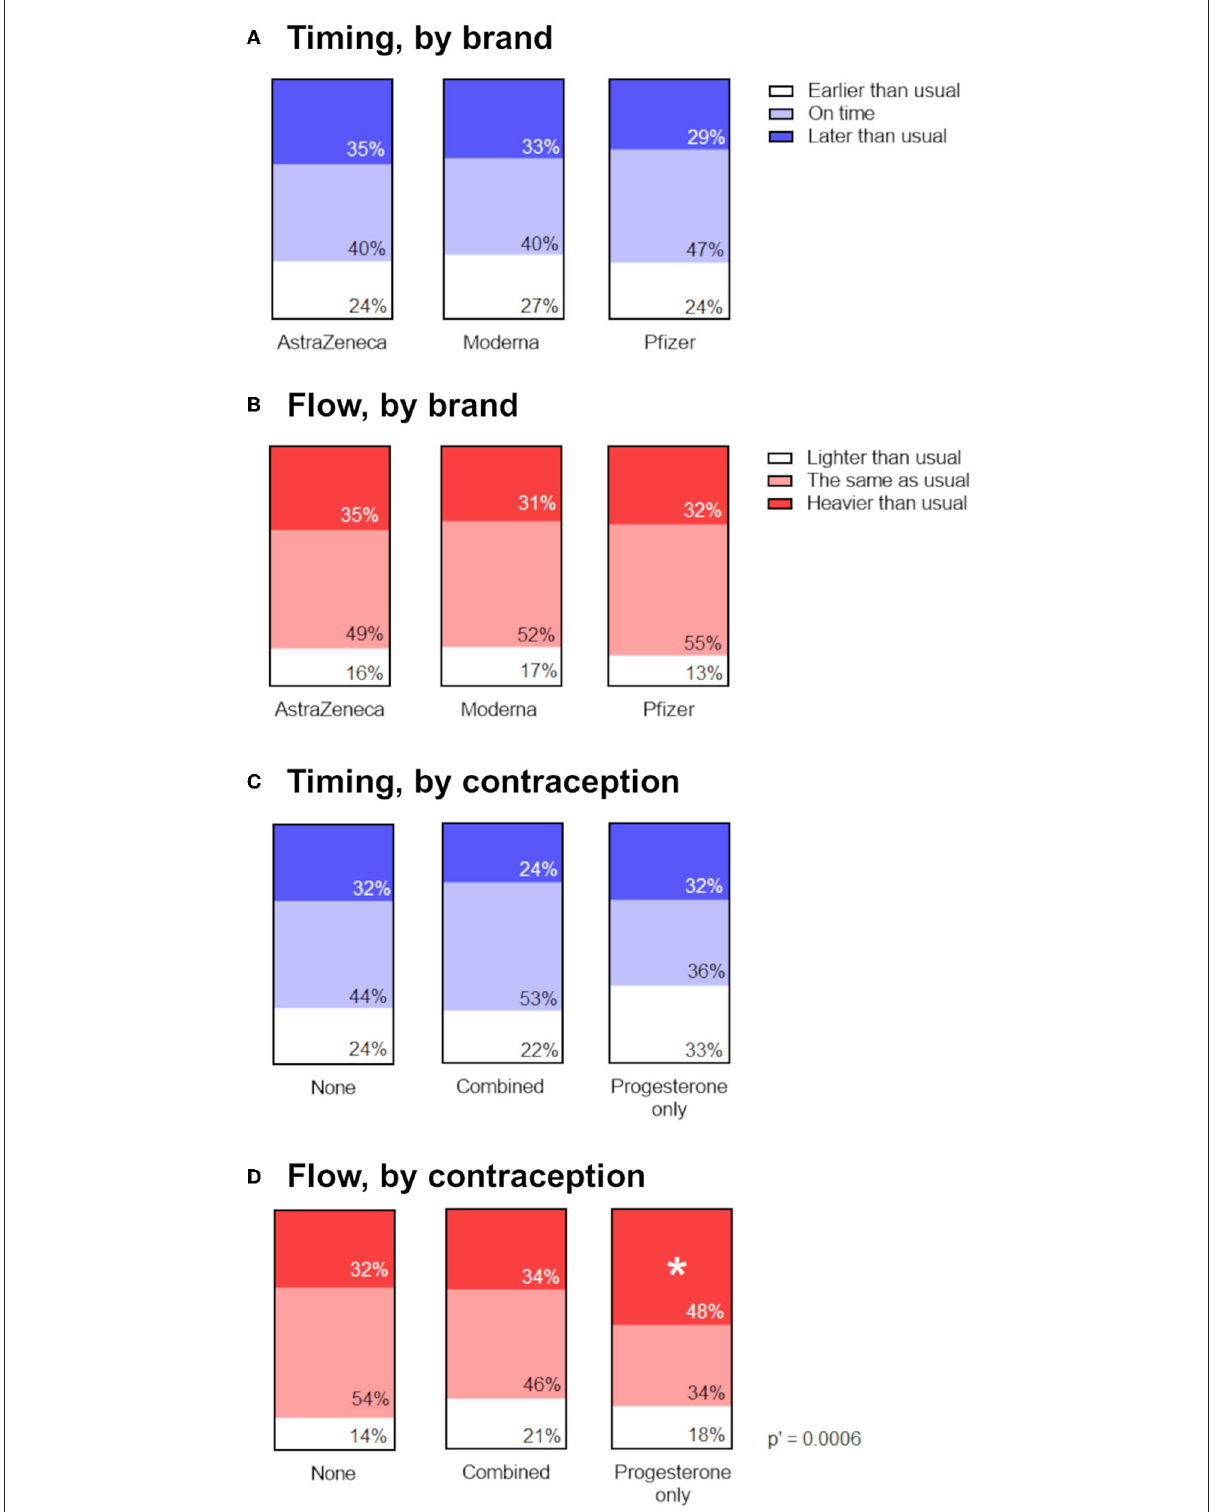
FIGURE3 Associations between menstrual changes and brand of vaccine, or use of hormonal contraception. (A,B) Proportional area charts depicting the proportion of participants who reported a change to the timing (A) or flow (B) of the period following vaccination, stratified by brand of vaccine. (C,D) Proportional area charts depicting the proportion of participants who reported a change to the timing (C) or flow (D) of the period following vaccination, stratified by type of hormonal contraception. Statistical testing with a Chi squared test with Holm-Bonferroni sequential correction for multiple hypothesis testing. Adjusted p -values are shown; * denotes categories in which the standardized residual is greater than the critical value